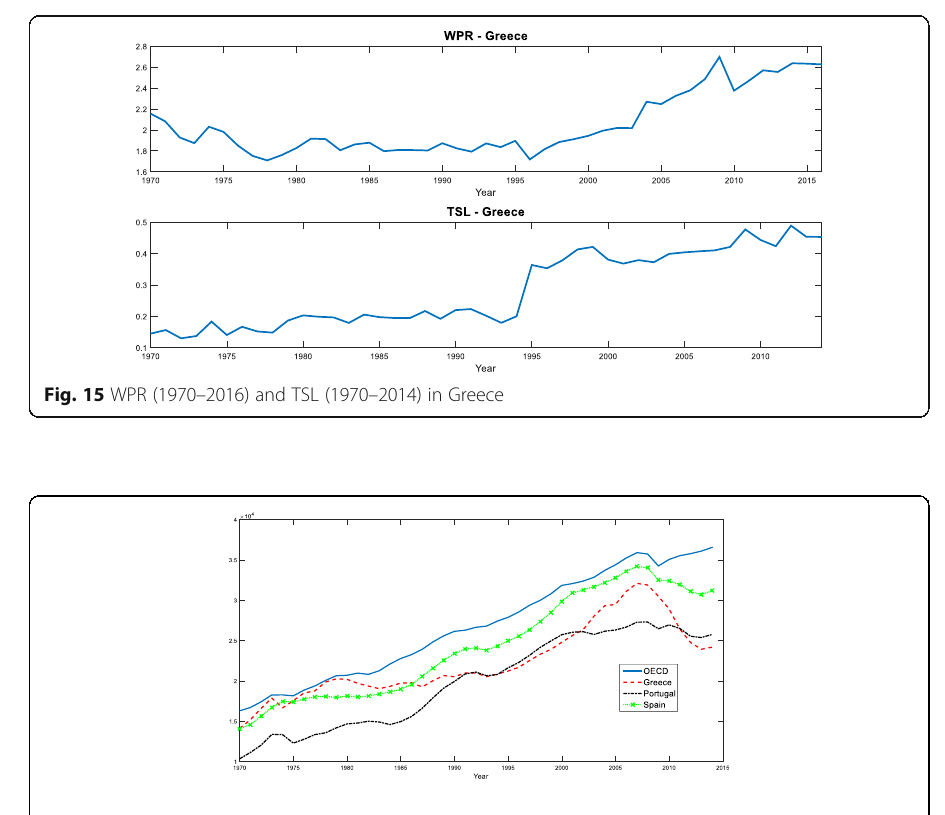
Fig. 16 Real per capita GDP in PPP values in Spain and Portugal vs Greece and OECD. Note : (i) Annual data over the period 1970 – 2014, (ii) per capita GDP is in constant 2010 prices and constant